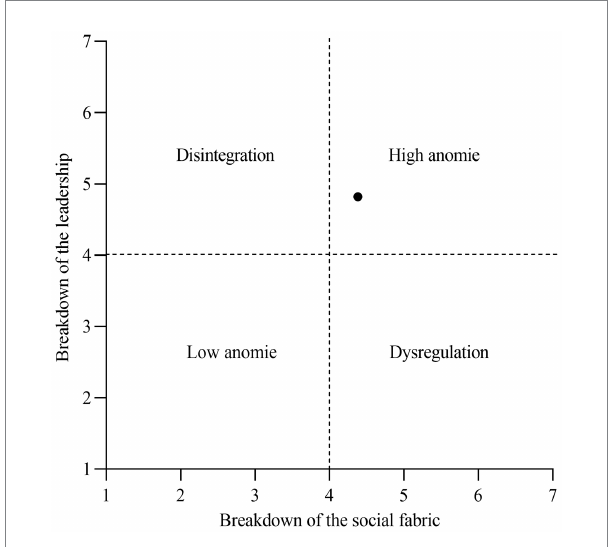
FIGURE 1 State of anomie based on means for rupture of the social fabric (4.38) and rupture of leadership (4.82) where the black dot indicates the location of Chile. Adapted from “Towards a psychological analysis of anomie” by Teymoori et al. (2017), Political Psychology , 38:1014 (doi: